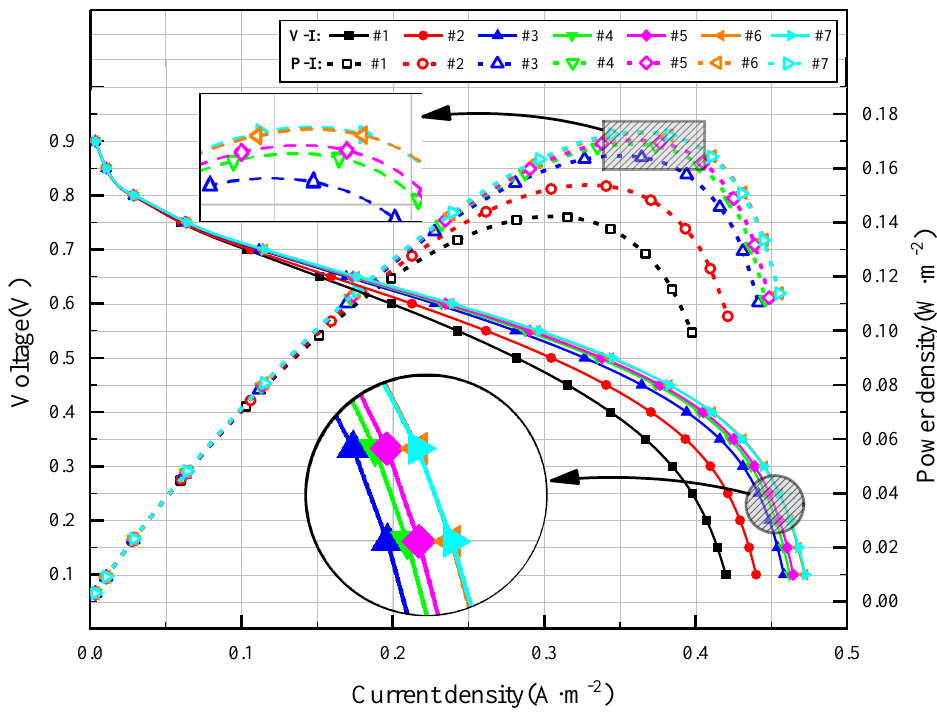
Figure 11. The polarization curves and power density curves between schemes #1 and #7. The polarization curve reflects the variation law between the voltage and current density of the fuel cell. It can be seen from the Figure that the voltage decreased with the increase in current density. At low current densities, schemes #1 to #7 all generated high voltages, and the difference between them was small. By contrast, the voltage gap between different schemes gradually increased at the intermediate and high current densities. This is because in these regions, as the number of polygonal sides increased, the total area of the flow channels gradually increased, which meant that the effective contact area between the reactant gas and the MEA also gradually increased, eventually causing the increase in the voltage produced by the fuel cell. What was shown from schemes #1 to #3 is that when the number of polygonal sides increased gradually, the voltage increased obvi- ously and greatly at the intermediate and high current densities, which meant that chang- ing the shape of polygonal structures at the beginning had a significant effect on the in- crease in voltage caused by the increase in the area of flow channels. However, the growth gap of voltages between schemes #4 and #7 became smaller with the continuous increas- ing polygonal sides. It is no doubt that the effect of the flow field structure on the fuel cell performance was diminishing. Especially between scheme #6 and scheme #7, the differ- ence in their polarization curves was negligible, which meant that the difference in the interaction between the flow channels and the ribs corresponding to the two schemes was similar. In brief, changing the structure can indeed improve the voltage generated by the fuel cell, but the principle of moderation should be followed. Blindly increasing the num- ber of polygonal sides cannot make the voltage produce a sustained and significant in- crease. The interaction between the flow channels and the ribs would eventually remain in a floating range and would not grow with the increasing number of polygonal sides. The same trend was reflected in the limiting current density of different schemes in Figure 12. The limiting current density from schemes #1 to #7 increased gradually, but the growth gap between adjacent two schemes decreased with the increasing number of polygonal sides. The difference between the limiting current density of scheme #6 (0.47205 A·m −2 ) and scheme #7 (0.47259 A·m −2 ) was even less than 0.1%.